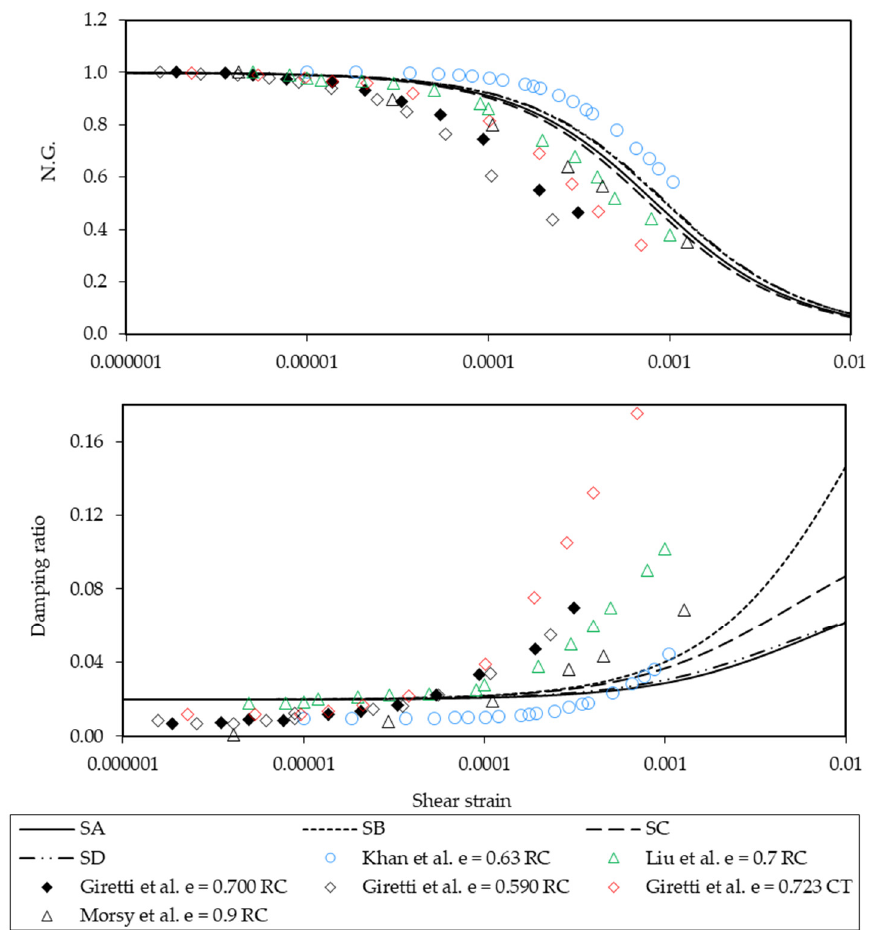
Figure 7. Comparison of proposed degradation models with selected studies on calcareous and silica sands at σ = 100 kPa from cyclic triaxial (CT) and resonant column (RC) tests. Silica sand data are represented with circular markers.